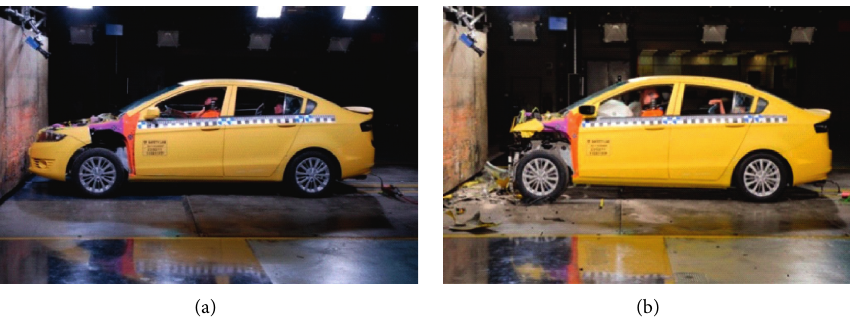
Figure 18: Test vehicle before and after the collision. (a) Before vehicle collision. (b) After vehicle collision.